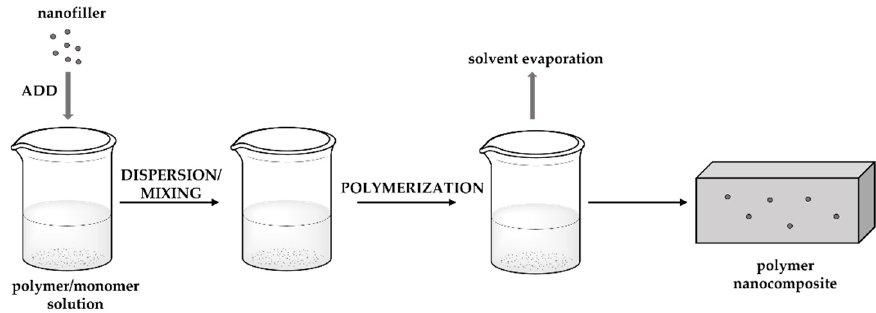
Figure 11. Schematic illustration in situ polymerisation method (adapted from [168]).